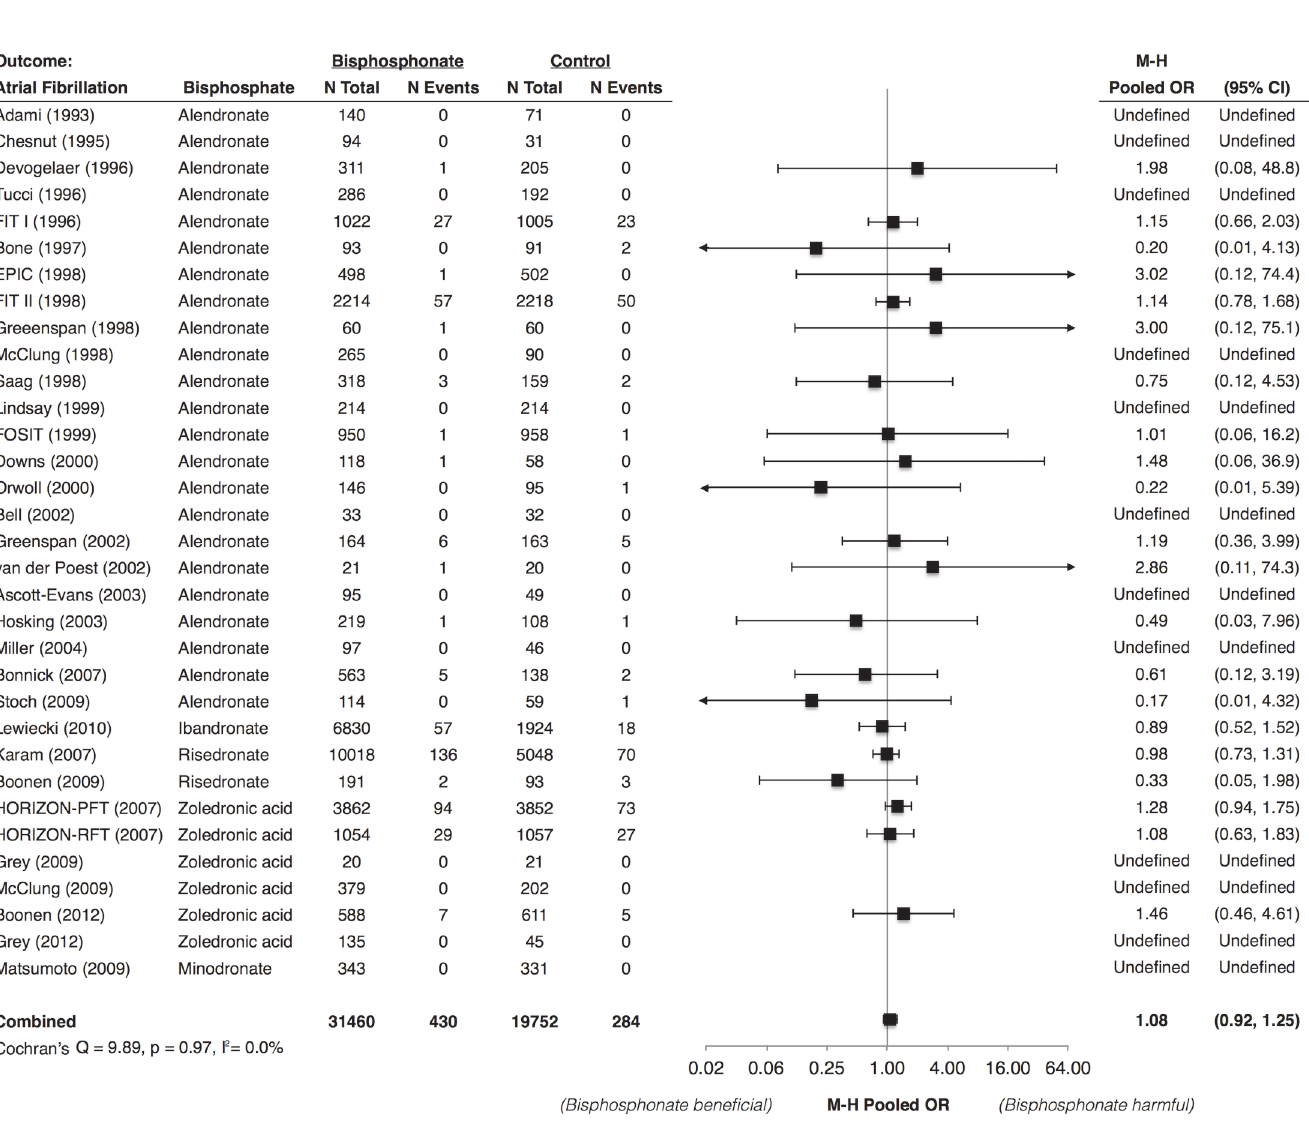
Fig 3. Meta-Analysis of Atrial Fibrillation Associated with Use of Bisphosphonates. * Abbreviations: CI, confidence interval; EPIC, Early Postmenopausal Intervention Cohort study; FIT, Fracture Intervention Trial; FOSIT, Fosamax International Trial; HORIZON-PFT, the Health Outcomes and Reduced Incidence with Zoledronic Acid Once Yearly Pivotal Fracture Trial; HORIZON-RFT, the Health Outcomes and Reduced Incidence with Zoledronic Acid Once Yearly Recurrent Fracture Trial; M-H, Mantel Haenszel; OR, odds ratio. * Lewiecki (2010) et al. included data from 4 trials of ibandronate. Karam (2007) et al. included data from 6 trials of risedronate. Individual study data were not